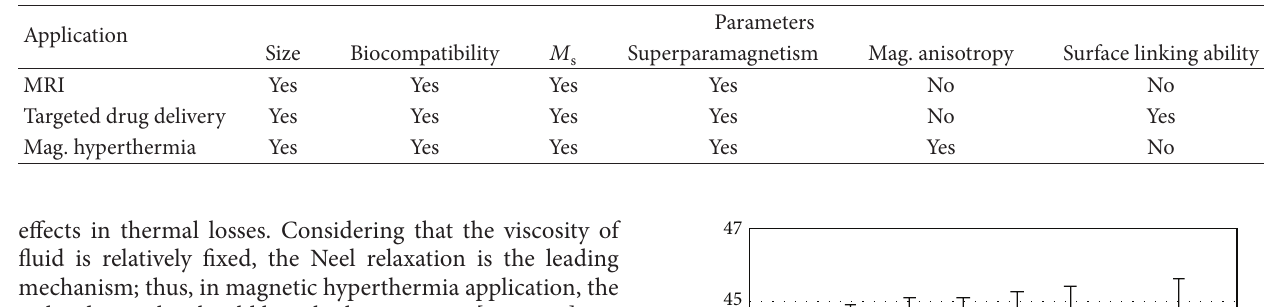
Table 7: The main effective parameters of magnetic particles in some bioapplications.